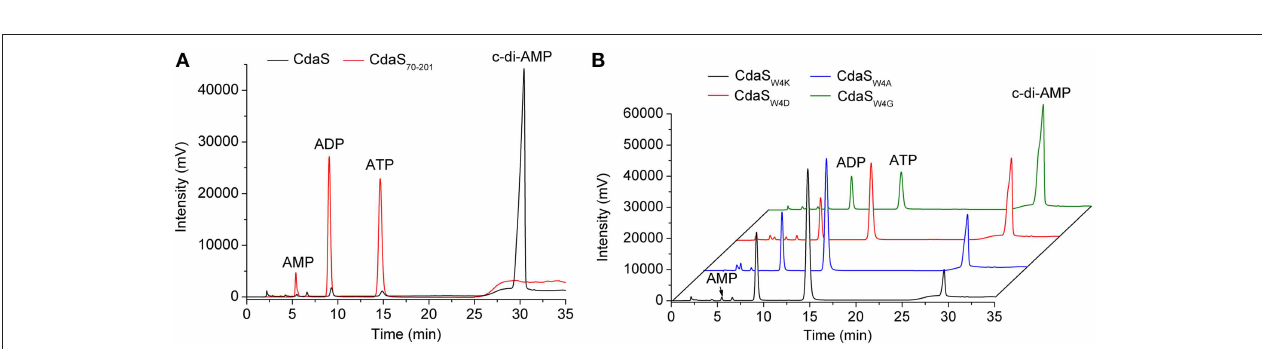
FIGURE 2 | Determination of the DAC activity of CdaS. (A) Using ATP as a substrate. 1 µ M CdaS was incubated with a standard reaction mixture (100mM HEPES buffer (pH 7.5) containing 200 µ M ATP and 10mM MgCl 2 ) at 37 ◦ C in a 500 µ L reaction volume. 100 µ L aliquots of the reaction were analyzed at different time points by HPLC. Black line: 10min; blue line: 20min; red line: 30min; green line: 40min. (B) Using ADP as a substrate. 1 µ M CdaS was incubated with a standard reaction mixture (except that 200 µ M ADP was substituted for ATP) at 37 ◦ C in 100 µ L reaction volume for 8h and then analyzed by HPLC.